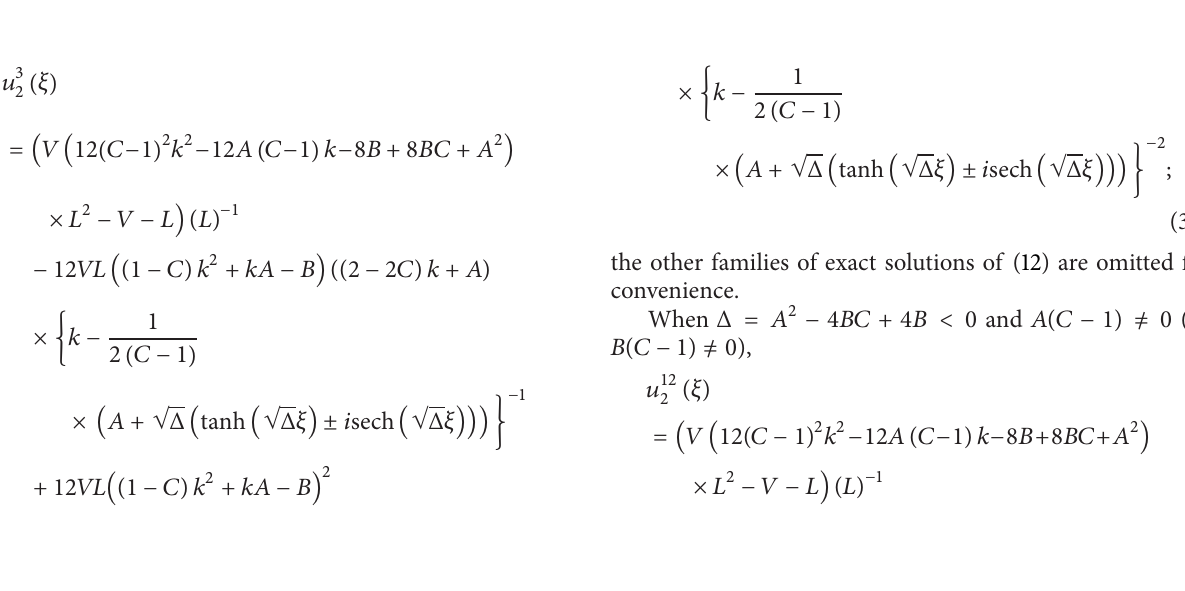
Figure 2: (a)–(d) show the bell-shape sec ℎ 2 solitary traveling wave solution for 𝑢 23 1 for different values of parameters.